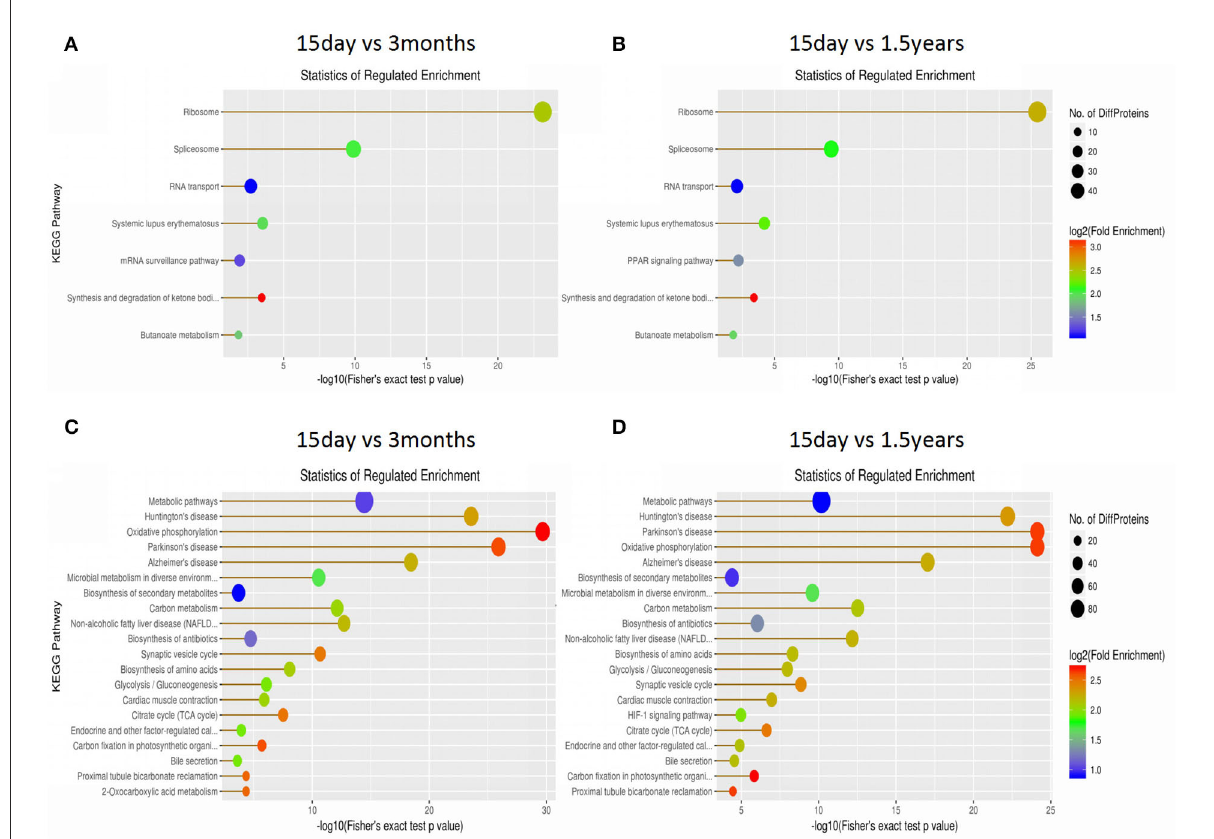
FIGURE4 The Kyoto Encyclopedia of Genes and Genomes (KEGG) pathway enrichment analysis of differentially expressed proteins. Each solid circle in the figure is a KEGG pathway term. The horizontal axis represents a significant p -value of the KEGG pathway enrichment, which is –log10. The larger the value is, the greater the enrichment is. The ordinate represents the name of the KEGG pathway classification. The size of solid circles represents the number of different proteins under the KEGG pathway classification, and the larger circles represent a larger number of different proteins. The color of the solid circle represents the enrichment multiple of the KEGG pathway classification, and the redder the color is, the greater the enrichment multiple is. (A) The upregulated protein pathway enrichment in the 15-day and 3-year age groups. (B) The upregulated protein pathway enrichment in the 15-day and 1.5-year age groups. (C) The downregulated protein pathway enrichment in the 15-day and 3-year age groups. (D) The downregulated protein pathway enrichment in the 15-day and 1.5-year age